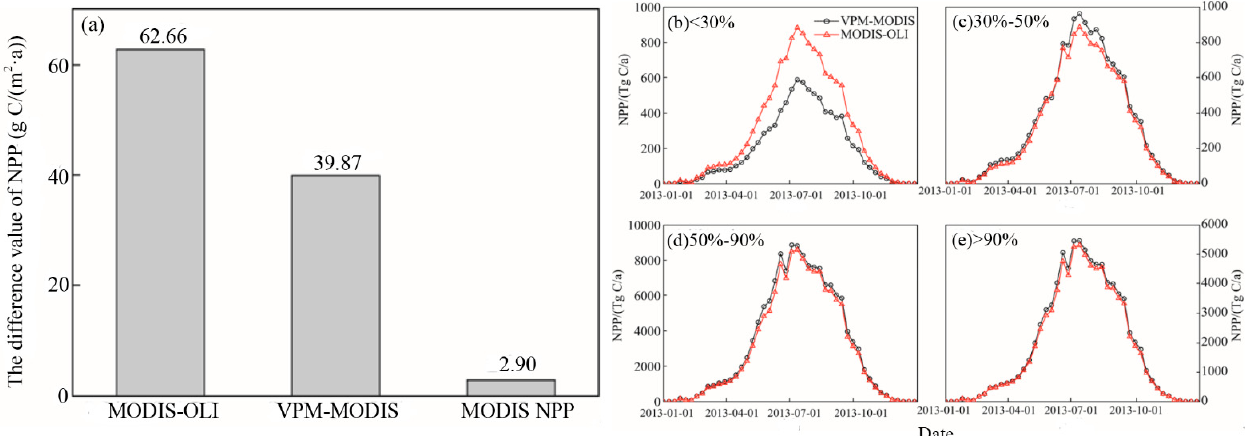
Figure 10. Comparison of the ability to simulate different NPP products on the change of cropland productivity: ( a ) Difference in cropland productivity inside and outside the high-standard farmland area, and ( b – e ) temporal changes in cropland productivity with different cropland coverage (drawing refers to [38]).